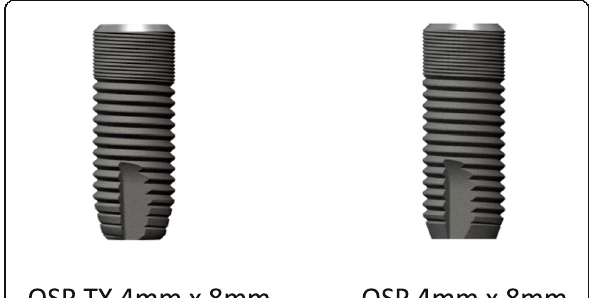
Fig. 1 Implant design. The OSPTX and OSP implants are manufactured from high-grade commercially pure titanium with surface roughness produced via a fluoride treatment process. The OSP implant is a screw-shaped self-tapping implant. The diameter used in this study was 4.0 mm. The implant length used in this study was 8 mm. The OSPTX implant has the same features as the OSP except the apex of the implant is